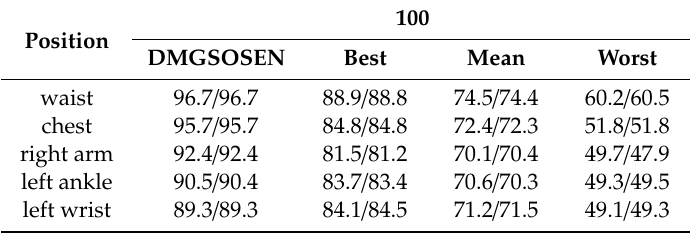
Table 3. Performance of the ensembles for initial pool sizes of 100 (Accuracy /